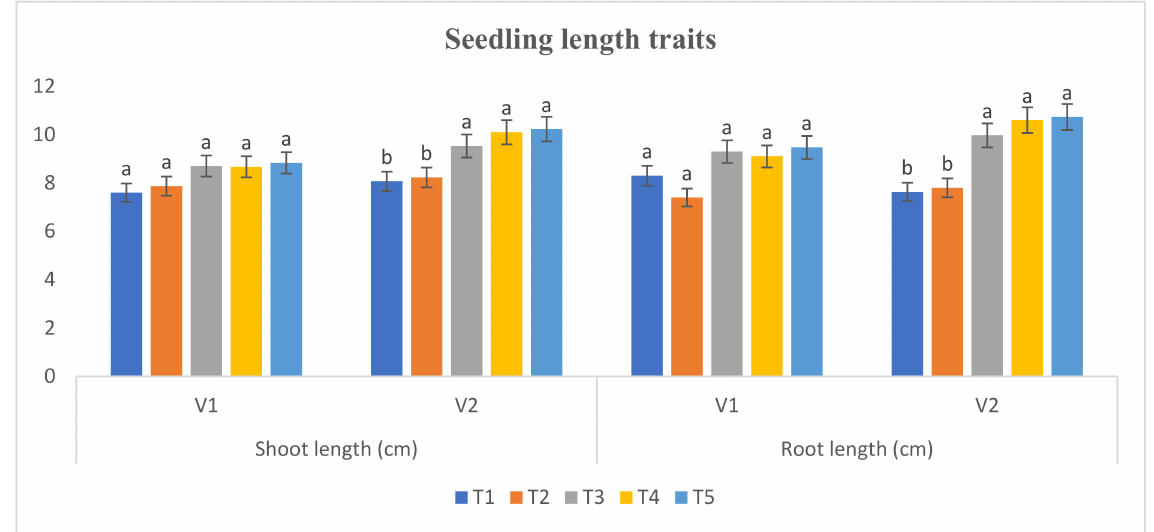
Figure 1. Shoot length (cm) and root length (cm) of wheat varieties under different priming treatments. The full description of abbreviations T1, T2, T3, T4, T5, V1 and V2 are represented in material and methods section. Lowercase alphabetical letters (a,b,c) represents the significant differences between the different seed priming treatments (Tukey test; p <